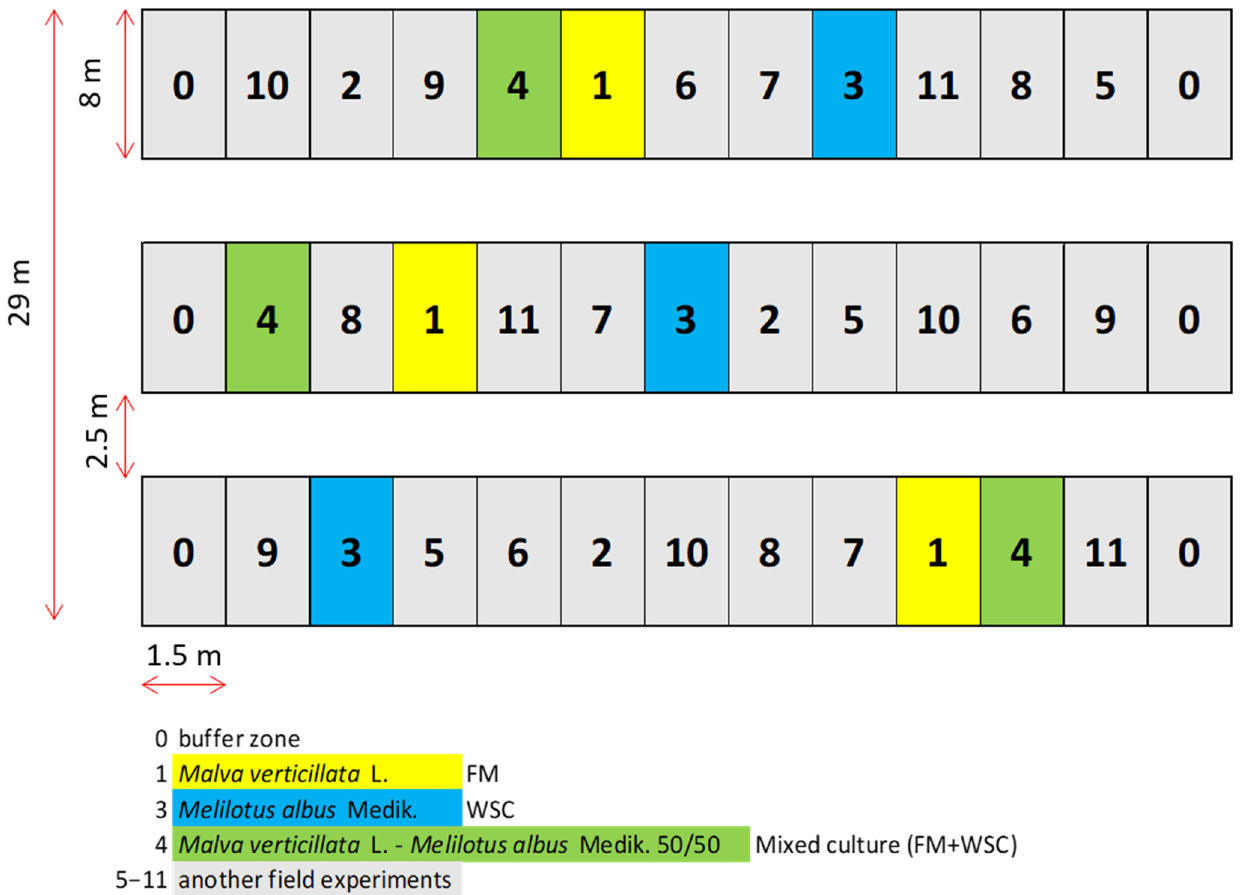
Figure 1. Organization of the field experiment. Field trial with 9 plots of FM (no. 1), WSC (no. 3) and FM + WSC (no. 4) of a size 8 × 1.5 m each.